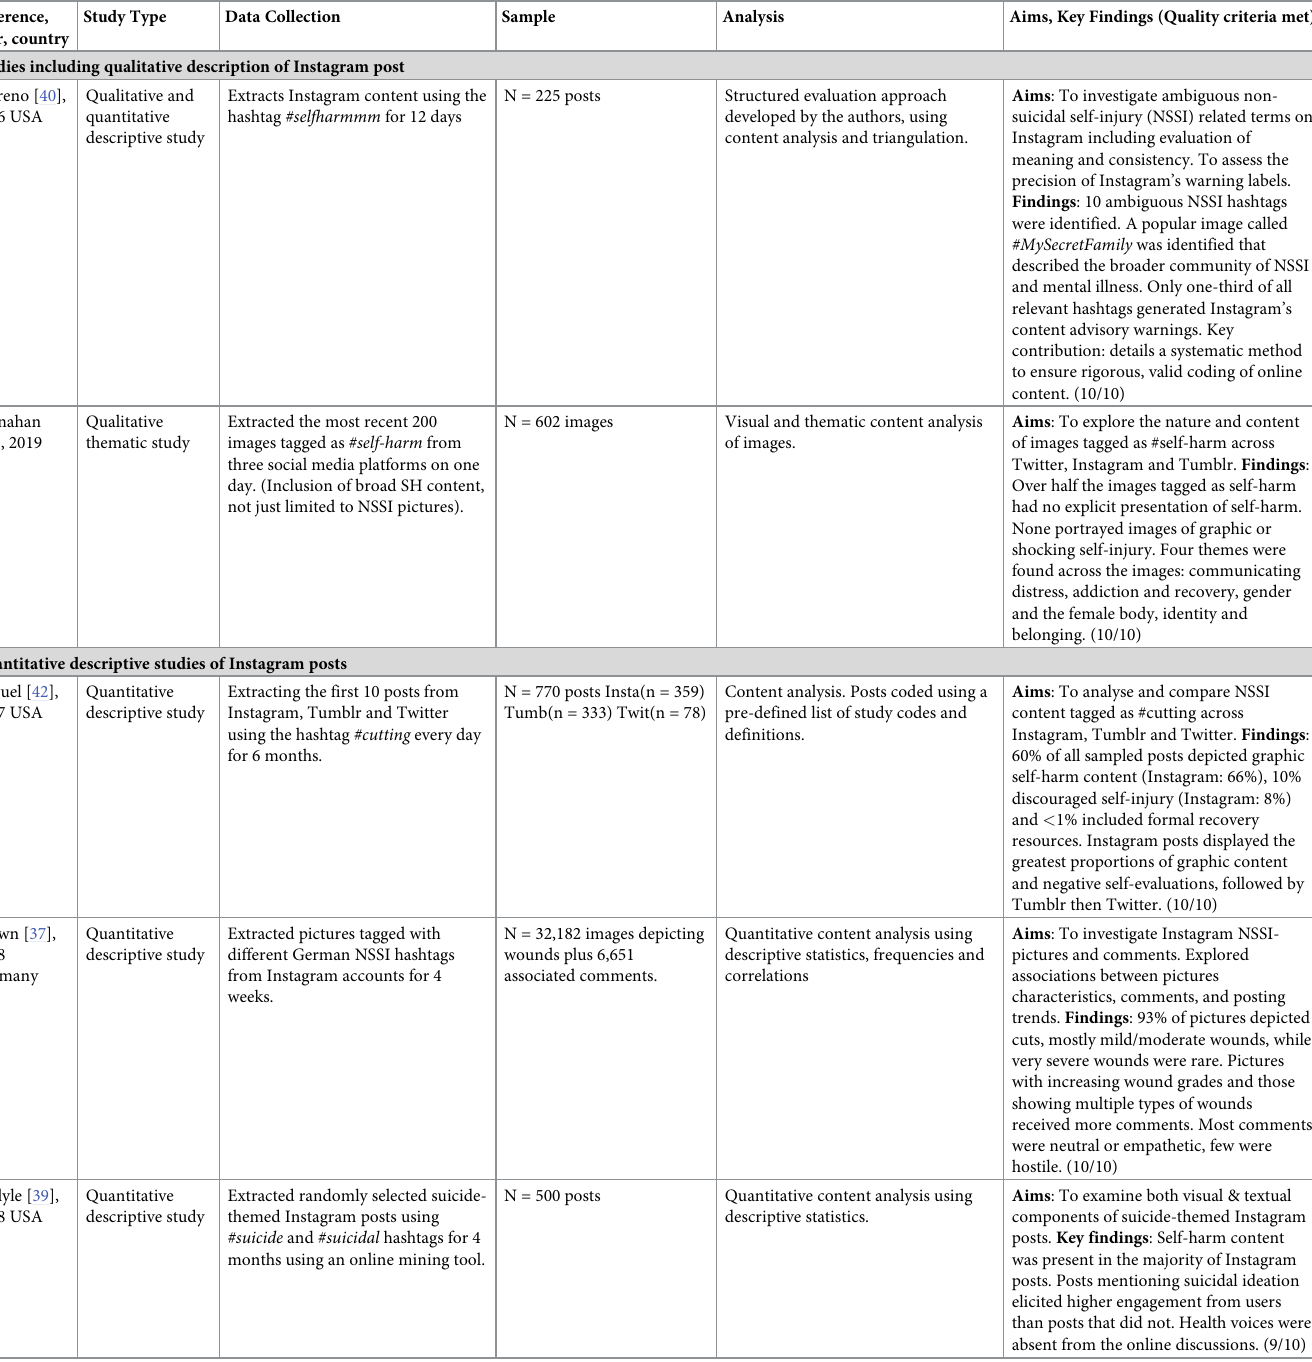
Table 1. Key characteristics of included